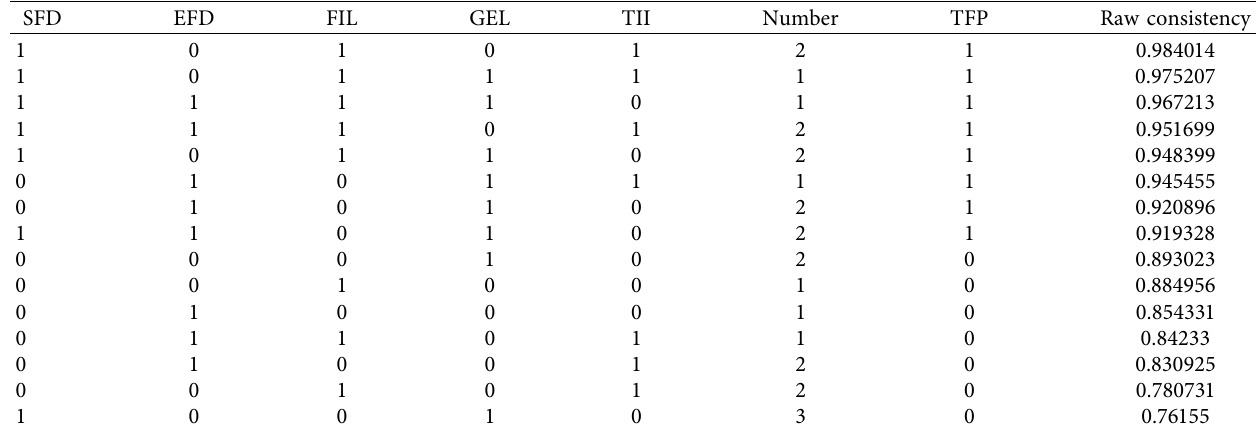
Table 4: Coding results.